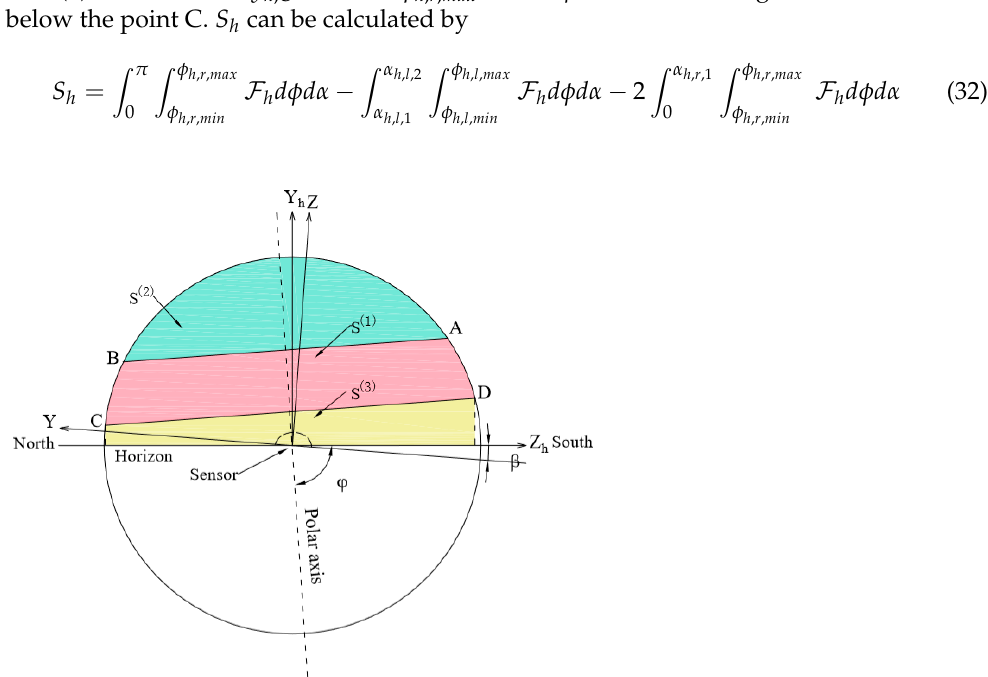
Figure 9. Schematic diagram for the calculation of 𝑆 (cid:3035) while 𝑑 (cid:3039) < 0 < 𝑑 (cid:3045) , 𝑦 (cid:3035),(cid:3003) > 0 and 𝜙 (cid:3035),(cid:3039),(cid:3040)(cid:3028)(cid:3051) < 𝜋 − 𝛽 .